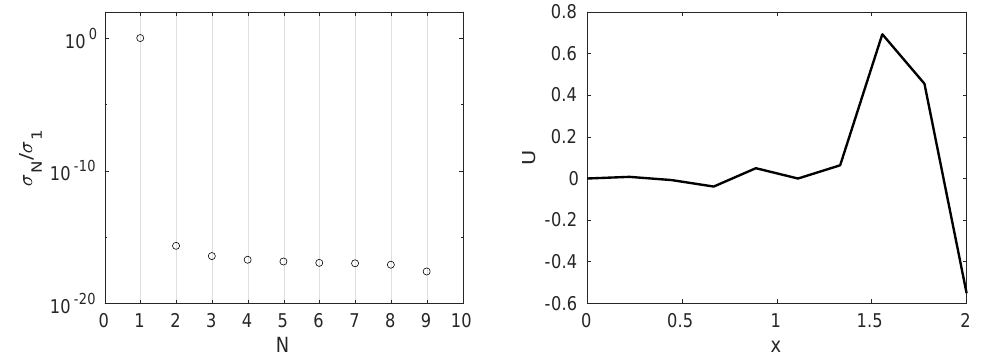
Figure 2. Singular values ( left ) and first SVD mode ( right ) calculated in the toy model